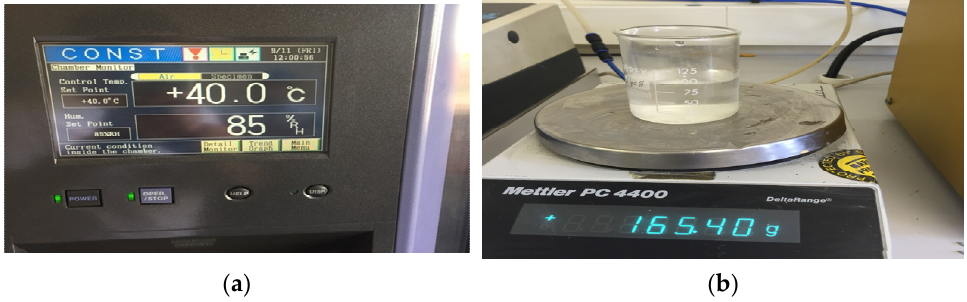
Figure 3. ( a ) Experimental setup; ( b ) water collected during the experiment.